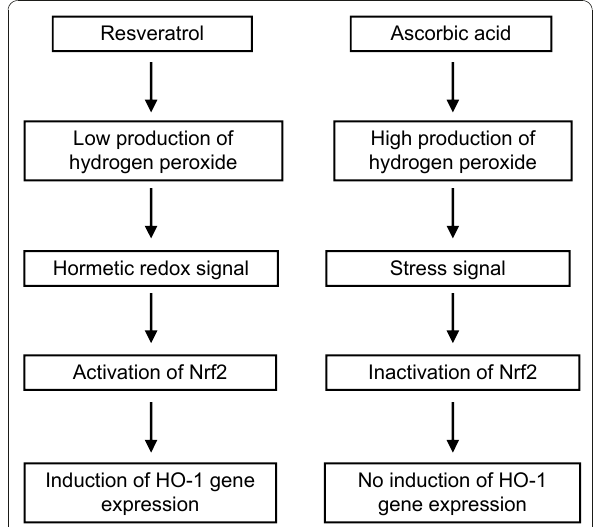
Figure 7 Potential molecular mechanisms by which resveratrol and ascorbic acid may affect Nrf2 signalling